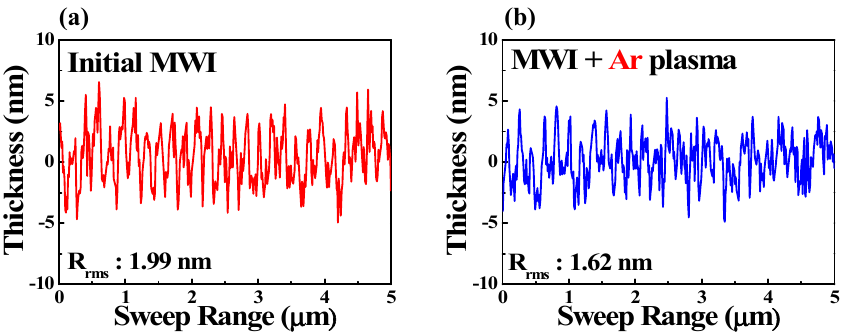
Figure 6. Surface roughness properties of MWI ITO films ( a ) before and ( b ) after Ar plasma treat- ment.